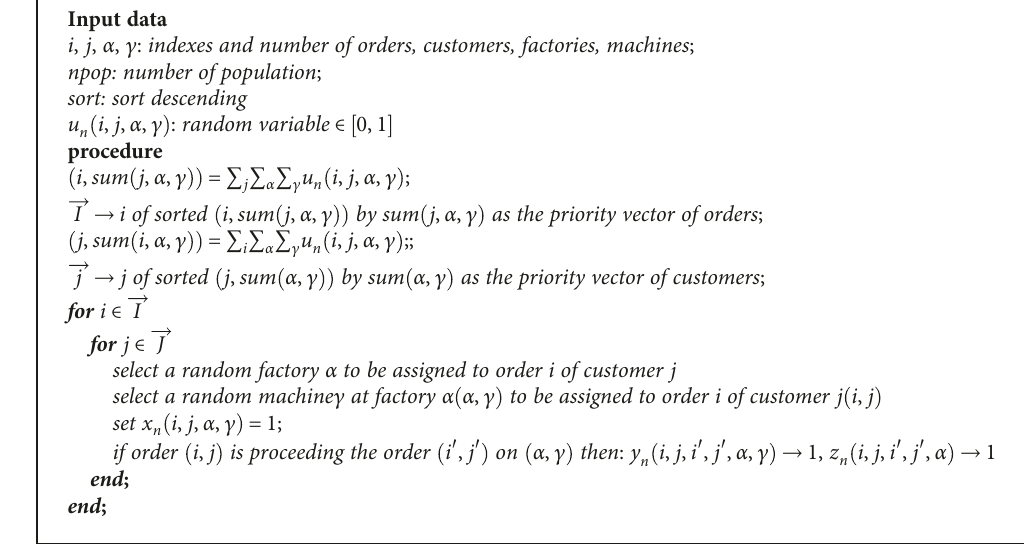
Algorithm 1: Decoding Mechanism P 1 .